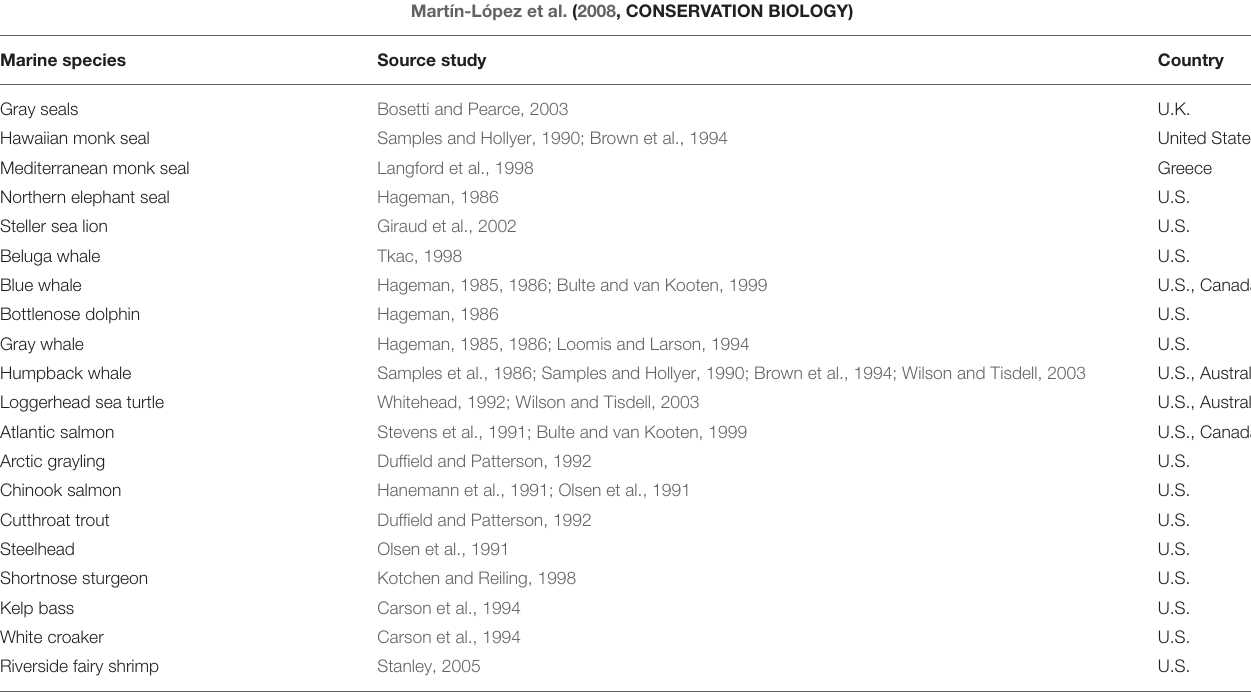
TABLE 1 | Threatened, endangered, and rare marine species values reported in